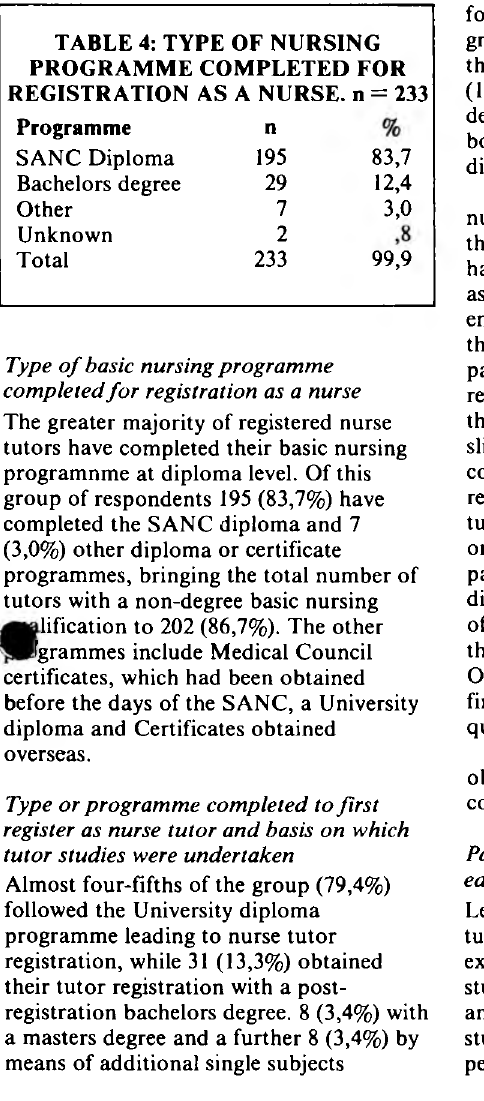
TABLE 5: TYPE OF PROGRAMME COMPLETED TO FIRST REGISTER AS A NURSE TUTOR